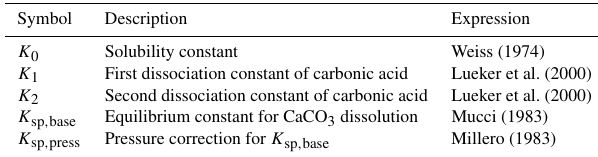
Table A4. The symbols and description of the equilibrium constants are presented in the first two columns. The third column presents the source of the used